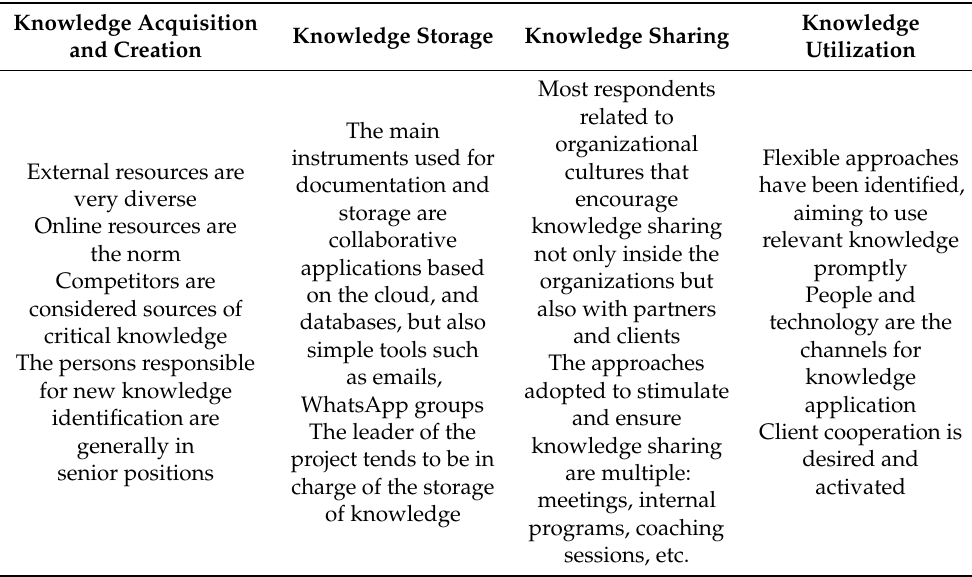
Table 2. The main lines followed by the KM processes in the Romanian